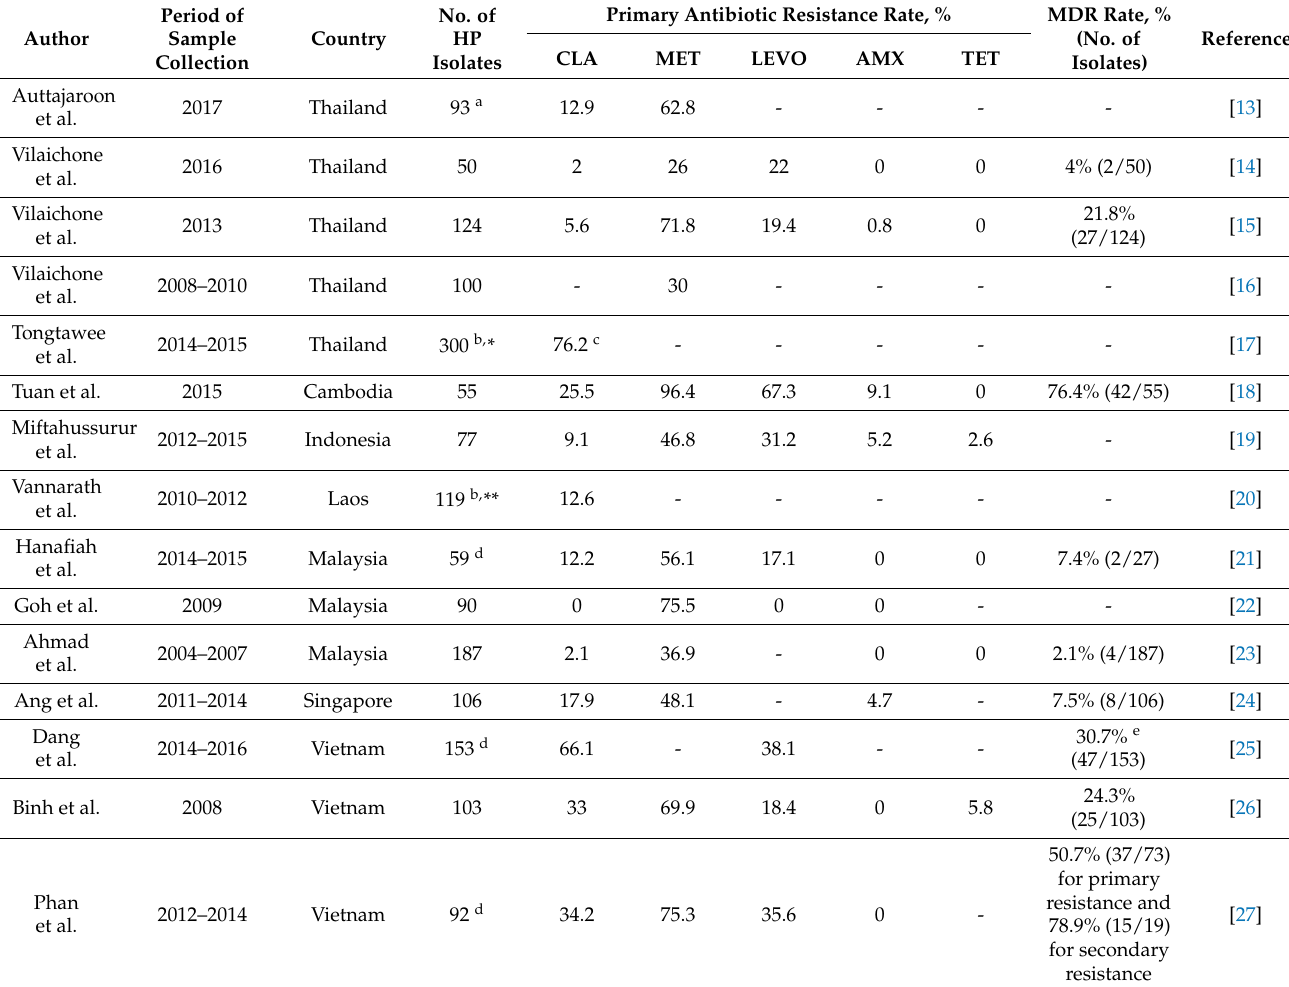
Table 2. Primary antibiotic resistance rates of H. pylori